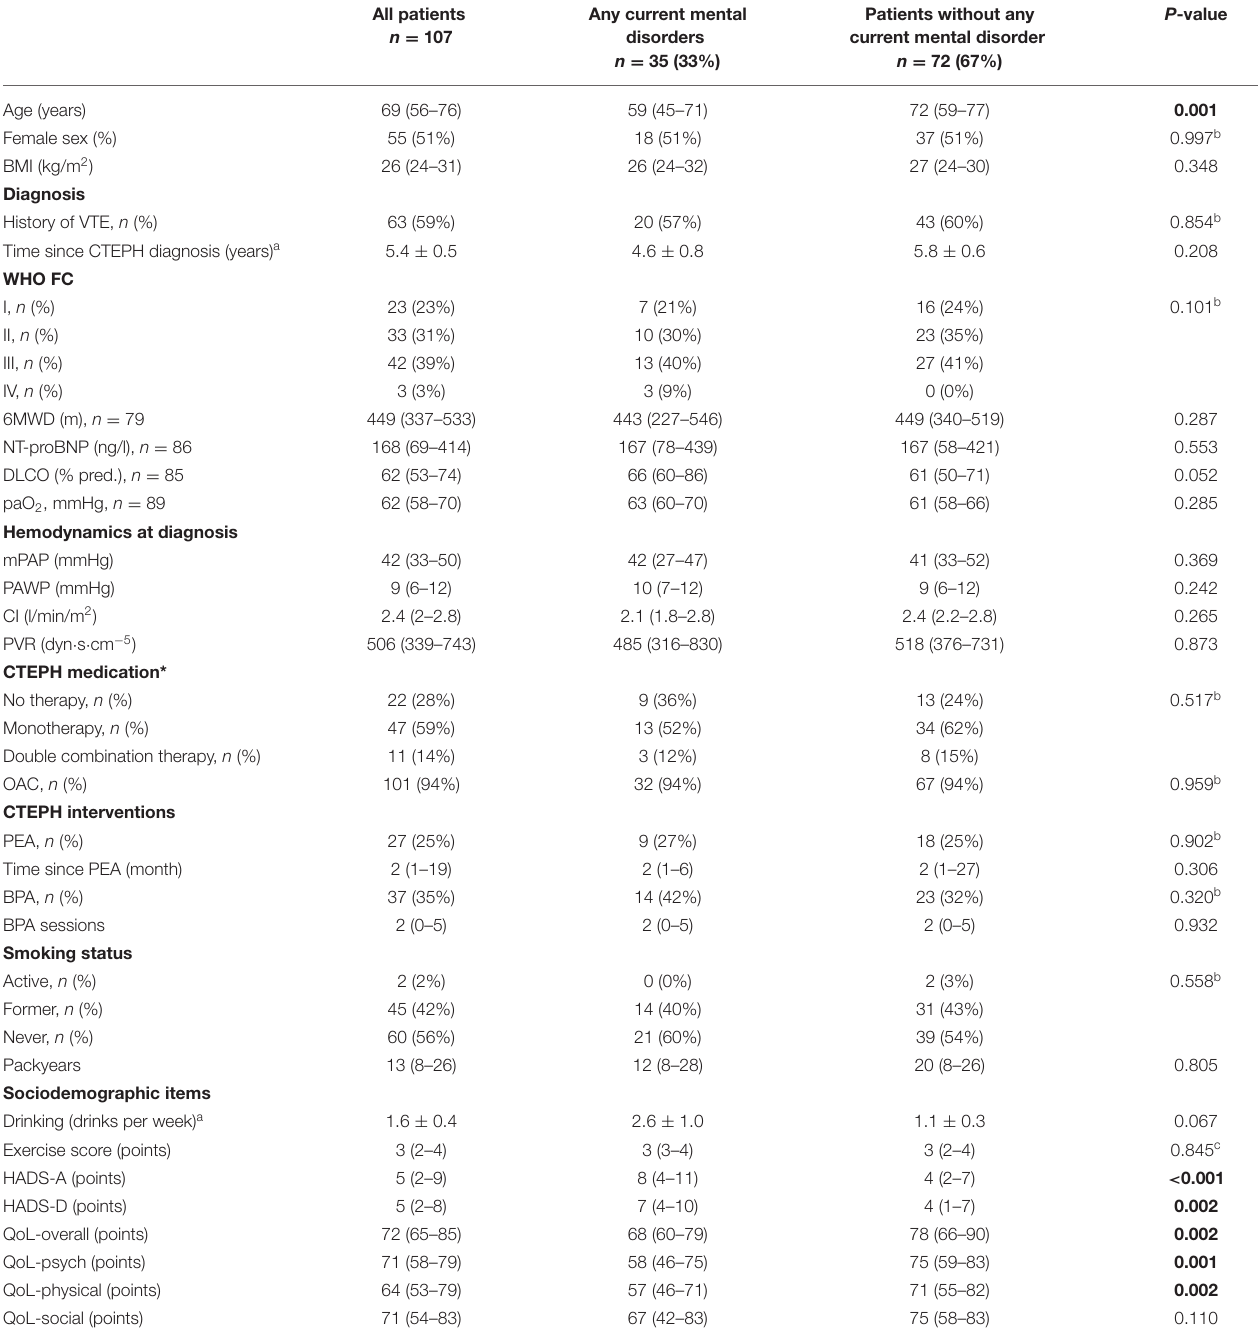
TABLE 1A | Characteristics of the patients at